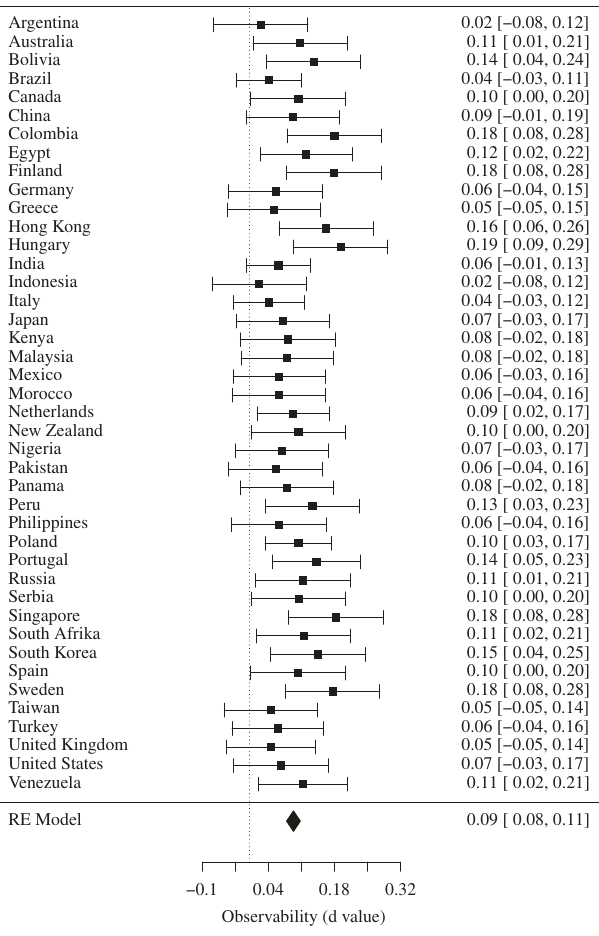
Fig. 2 Effect sizes of observability across nations. Forest plot displaying effect size of observability predicting cooperation. For each nation, we report estimated standardized mean difference (Cohen ’ s d c ) and 95% con fi dence interval in the right side of the plot. A positive d value indicates higher cooperation in the public treatment compared to the private treatment. The overall estimated population effect sizes are represented by the black diamonds, which correspond to the 95% con fi dence interval. Source data are provided as a Source Data fi